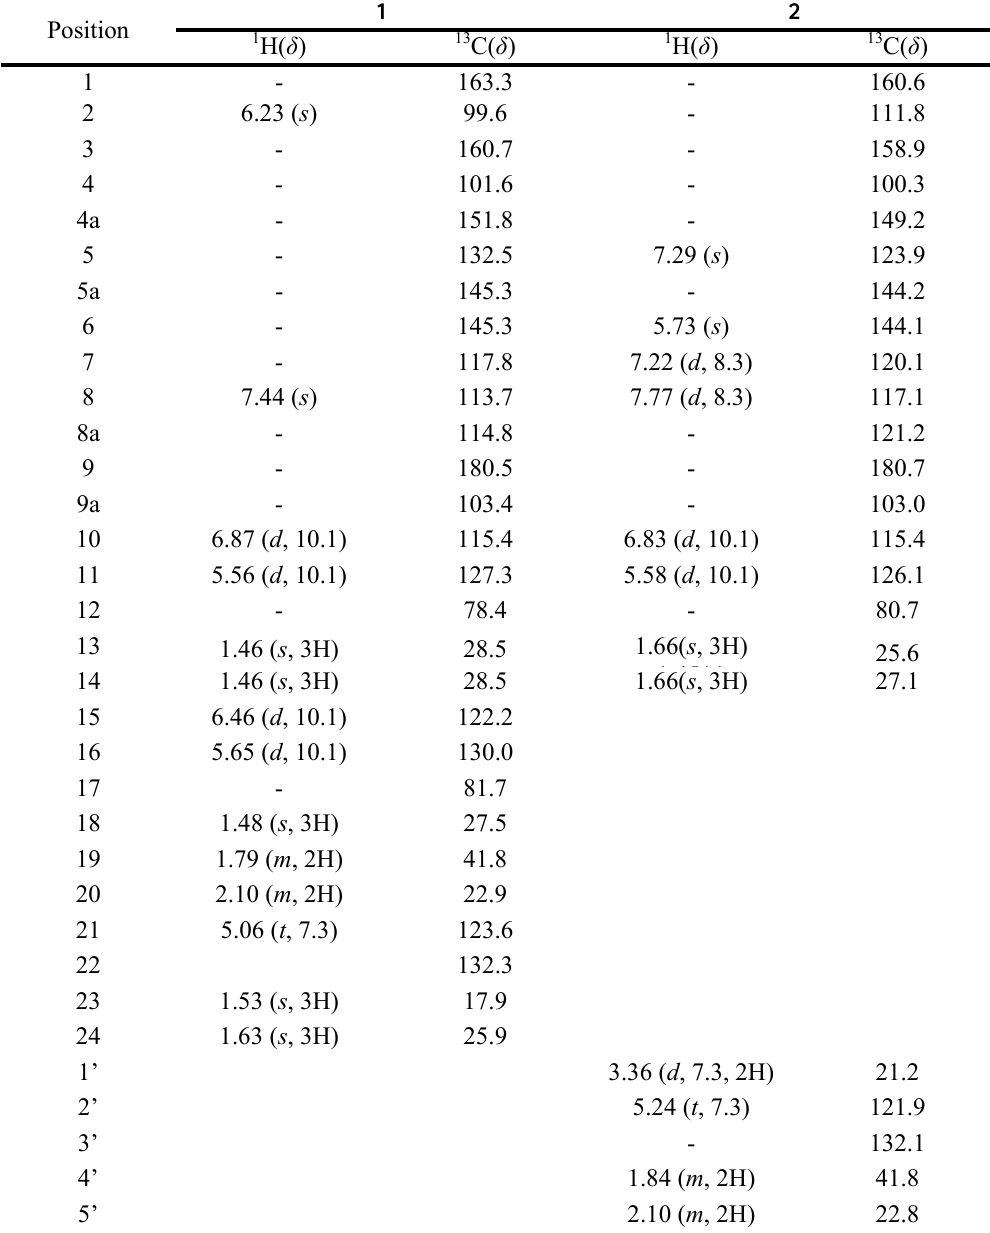
Table 1. 1 H-NMR (400 MHz, CDCl mesuarianone ( 1 ) and mesuasinone ( 2